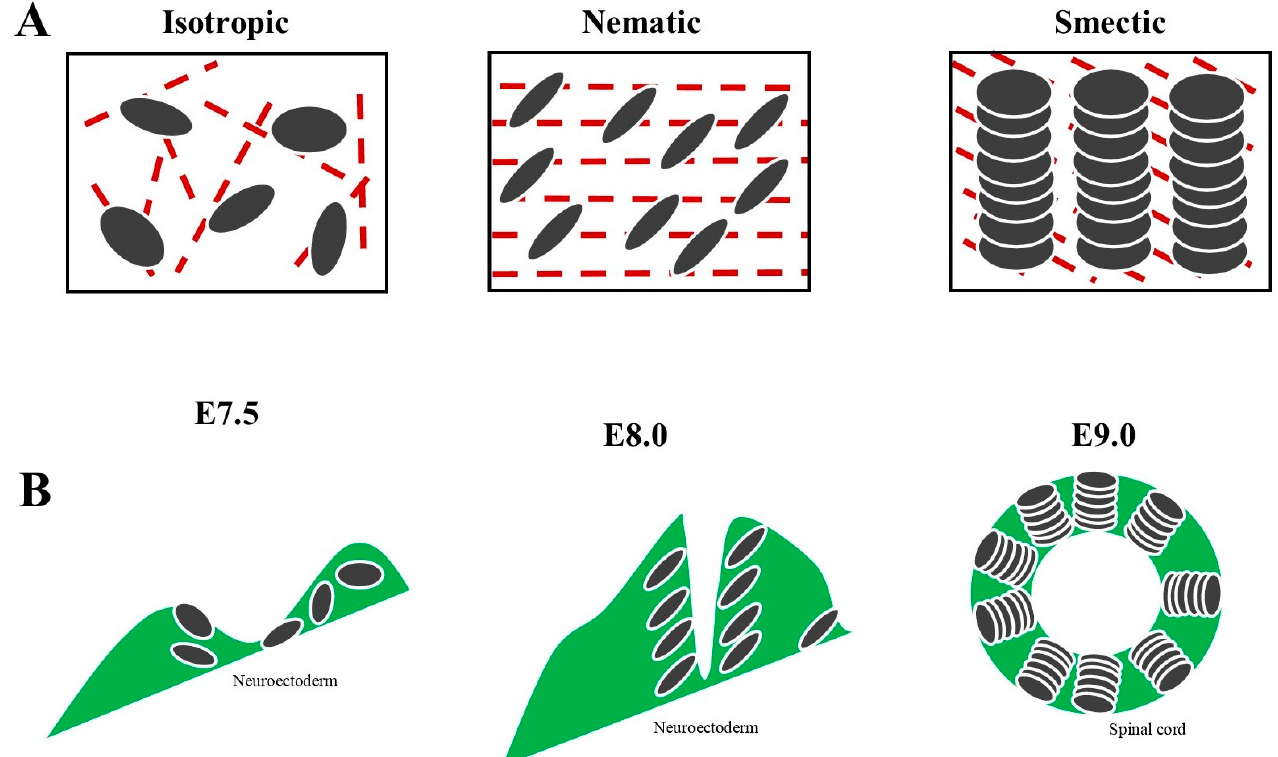
Figure 2. Comparison of two seemingly uncorrelated phenomena, i.e., liquid crystal phases and embryonic development of the nervous system. ( A ) Mixtures of molecular/colloidal rods and disks of fluid-condensed matter give rise to temperature-dependent columnar chains displaying different uniaxial symmetries. Depending on the structural arrangement, we achieve isotropic, nematic and smectic liquid crystals. For further details, see [91]. ( B ) Schematic transverse sections of neurulation in the mouse embryo at different stages of development. While the primitive confined neuroectoderm at E.75 recalls isotropic liquid crystals ( left picture ), the converging neural folds at E8.0 remind the arrangement of nematic liquid crystals ( middle picture ). In turn, the spinal cord at E.9.0 evokes the typical arrangement of smectic liquid crystals ( right picture ). For further details, see [94].